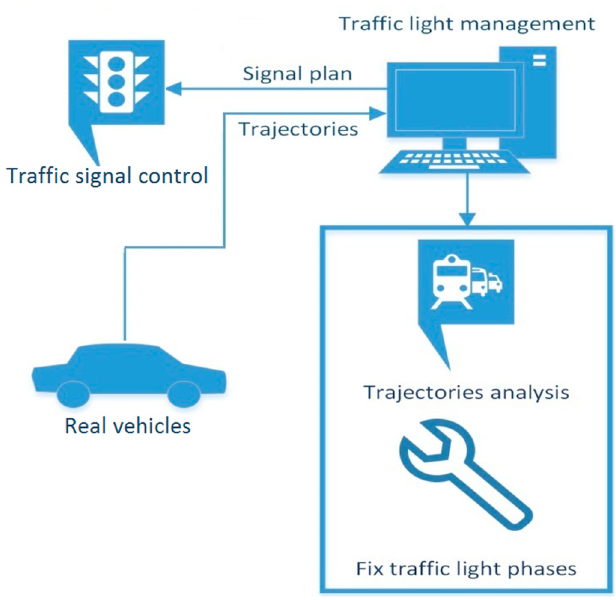
Figure 3. Traffic signal management in the on-field experiment. Figure 3. Tra ffi c signal management in the on-field